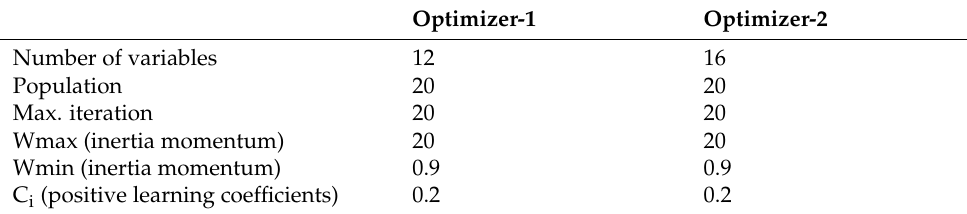
Table 4. The parameters of PSO algorithms for both optimizers. Optimizer-1 Number of variables 12 16 Population 20 20 Max. iteration 20 20 Wmax (inertia momentum) 20 20 Wmin (inertia momentum) 0.9 0.9 C i (positive learning coefficients) 0.2